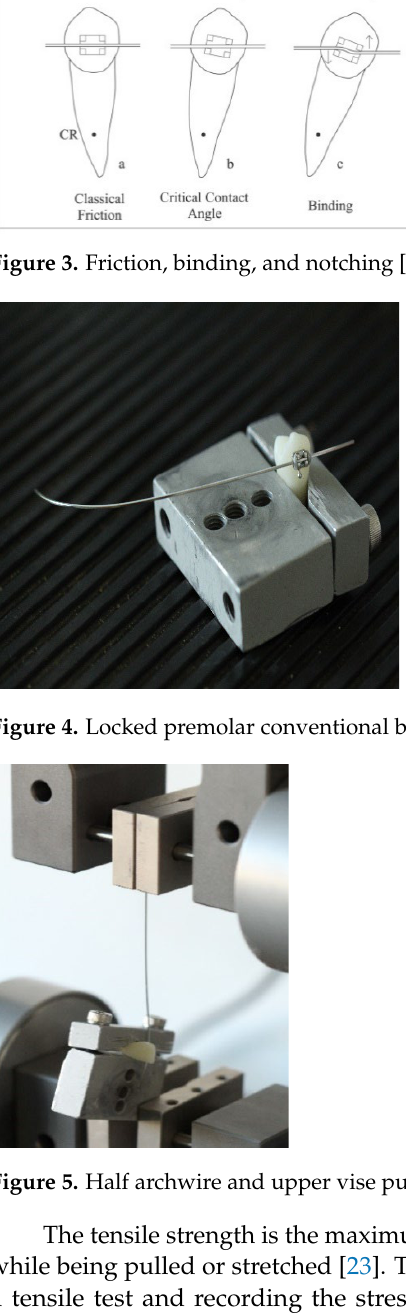
Table 3. Dunn’s post hoc test—tensile strength.